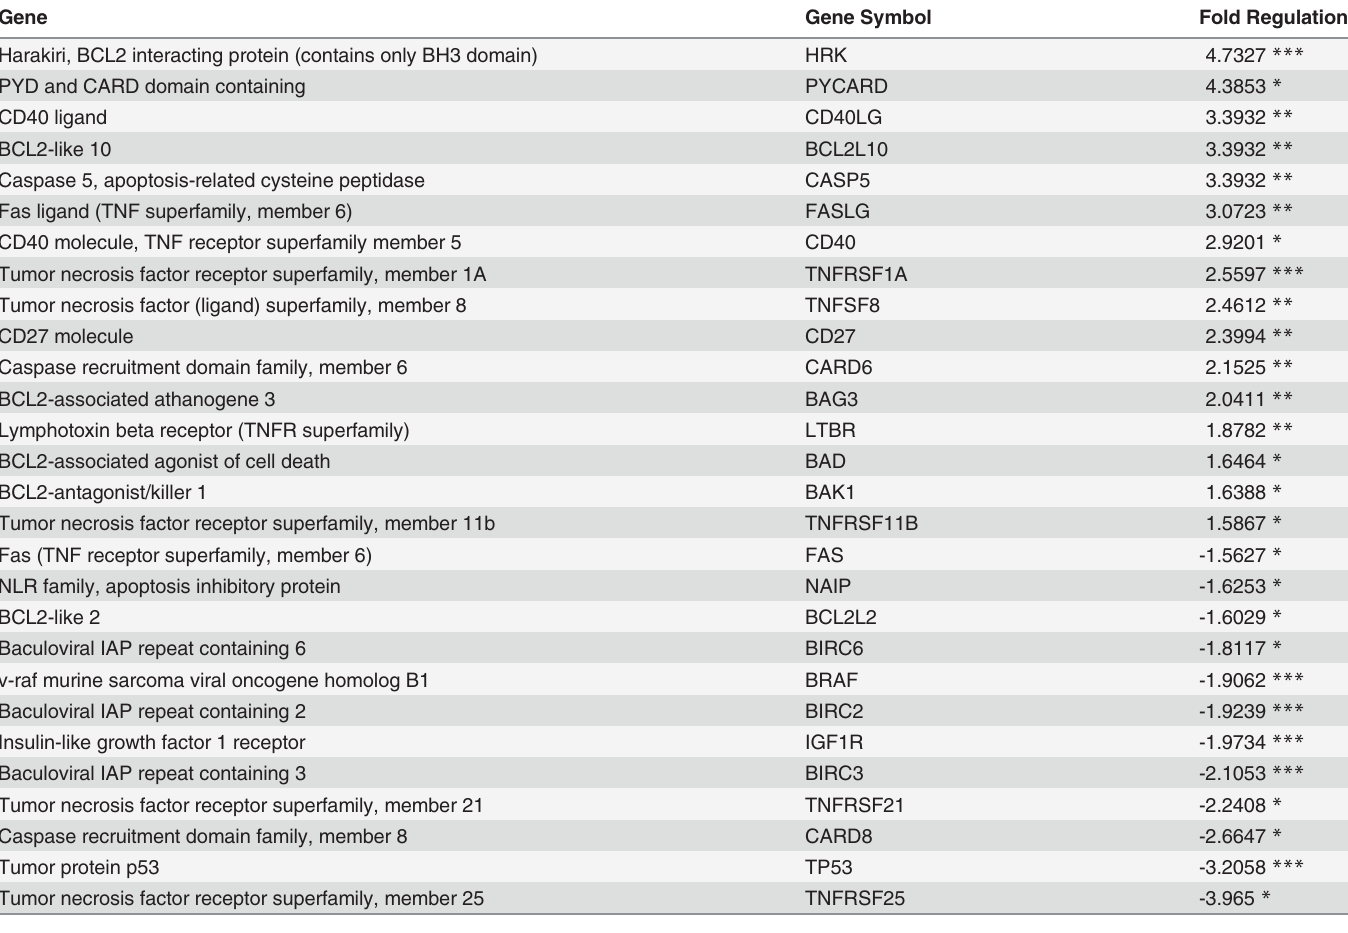
Table 1. Genes that were found to be statistically significant in the experiment, classified by their fold regulation and stimulation/inhibition of genes involved in apoptosis pathway. Gene Gene Symbol Harakiri, BCL2 interacting protein (contains only BH3